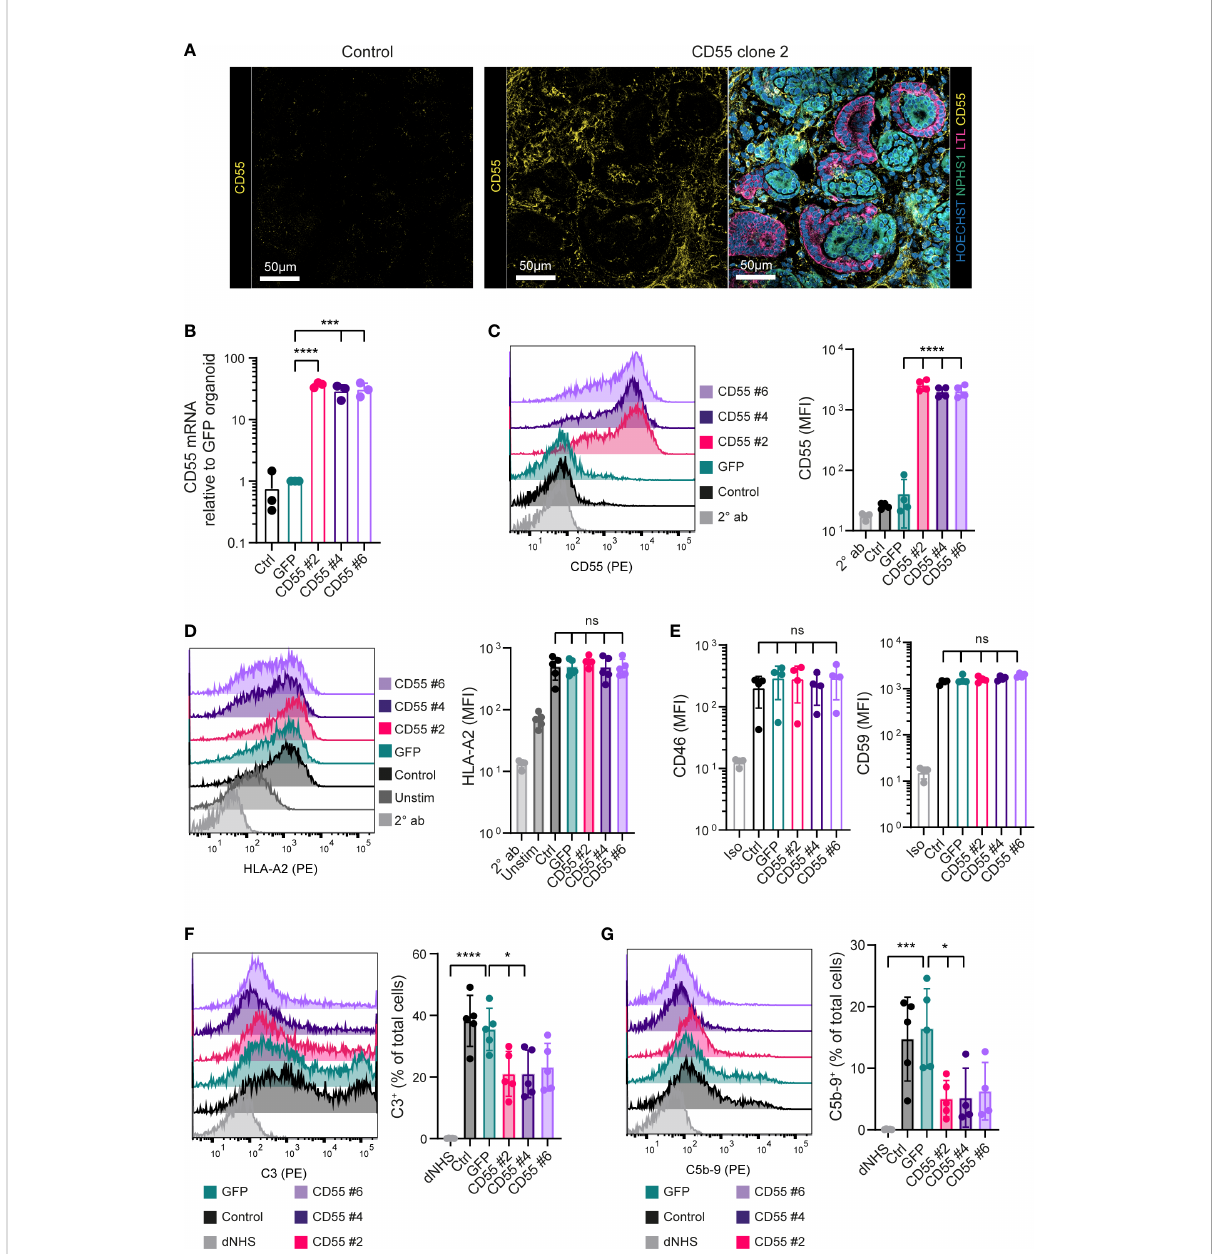
FIGURE 5 CD55 overexpression in kidney organoids decreases complement deposition. (A) Representative fl uorescent images of organoids with detection of CD55 (yellow) in high magni fi cation. For the CD55 #2 organoid an image with detection of Hoechst (blue), NPHS1 (green), LTL (pink) and CD55 (yellow) of the same area as the separate CD55 image is included. Other clones are included in Supplemental Figure 4. (B) CD55 mRNA expression in organoids at day 7 + 14 measured by RT-qPCR (n=3). (C) CD55 protein expression in dissociated kidney organoids at day 7 + 14 measured by fl ow cytometry showing a representative histogram of 5 independent experiments (n=5). Staining with only PE-conjugated secondary antibody (2° ab) is shown in light grey. (D) Cell surface opsonization by anti-HLA-A2 in unstimulated (Unstim) and IFN- g stimulated (Ctrl, GFP, CD55 #2, 4 and 6) kidney organoid cells measured by fl ow cytometry. A representative histogram is shown of 5 independent experiments (n=5) and staining with only PE-conjugated secondary antibody (2° ab) is shown in light grey. (E) CD46 and CD59 protein surface expression on kidney organoid cells measured by fl ow cytometry (n=5). Staining with isotype (Iso) is shown in light grey. ( F , G ) C3 and C5b-9 deposition on kidney organoid cells incubated with normal human serum (NHS) measured by fl ow cytometry. Incubation with heat-inactivated NHS (dNHS) was used as negative control and is shown in light grey. Results are presented as C3 + or C5b-9 + proportion. A representative histogram is shown of 5 independent experiments (n=5). Error bars show standard deviation and signi fi cance (*p < 0.05; ***p < 0.001; ****p < 0.0001) was evaluated using one-way ANOVA comparing each sample to iPSC-GFP-derived kidney organoids with Dunnett correction for multiple comparisons. ns, non signi fi